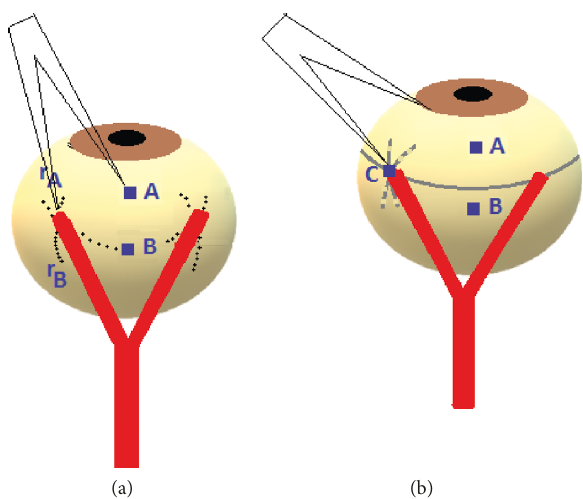
Figure 1: A sketch of Y-split recession, side view. (a) The first orientation point (“A”) is given by the middle of the natural muscle insertion. The second orientation point (“B”) is located 6mm straight behind A. With a compass, the distance r A is marked with color on the globe. The same procedure is repeated from B, with the distance r B . The intersection of the two marked lines indicates the new insertion points for the split-muscle halves. (b) The “control distance” (“C”) ensures correct placement of the new insertion